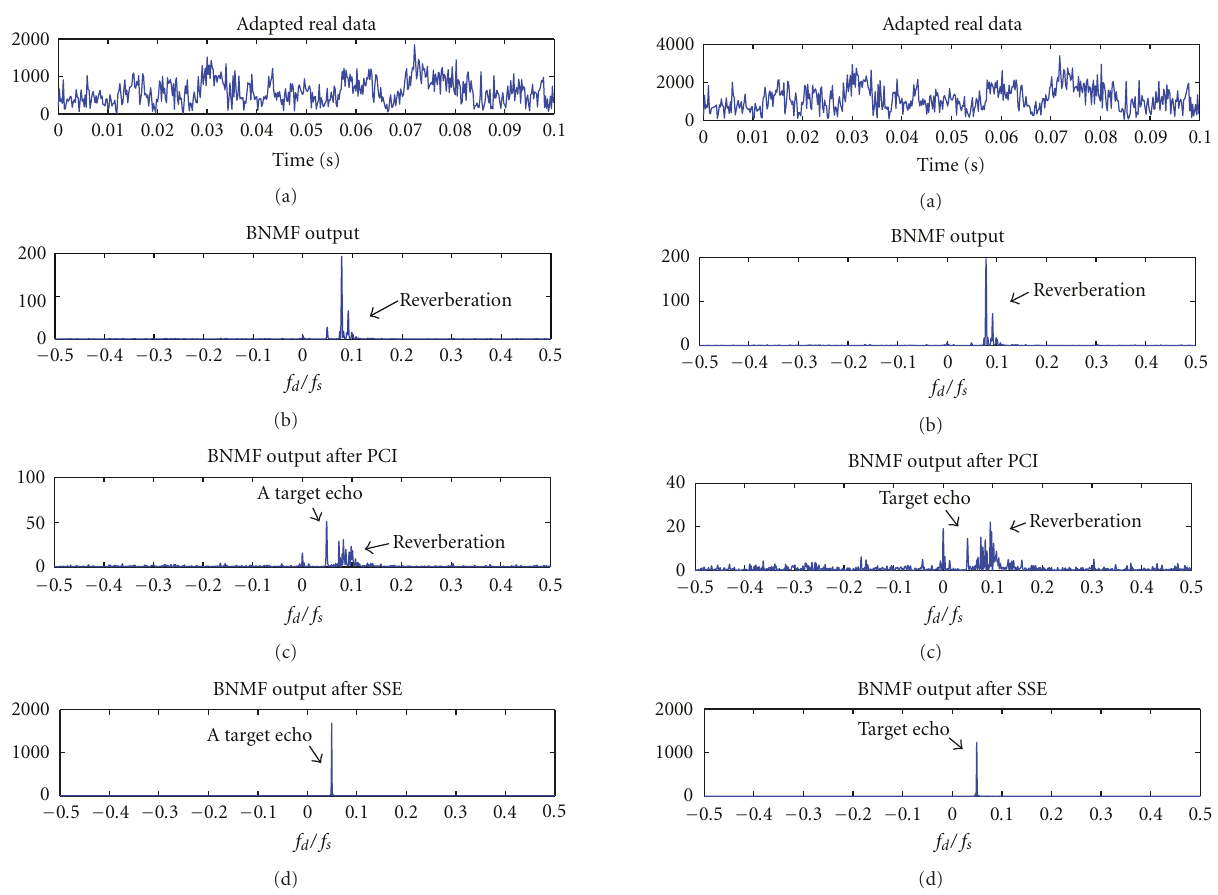
Figure 1: Adapted active sonar data, BNMF outputs without processing, and after PCI and SSE with SSR = − 12 dB, f d / f s = 0 . 049.